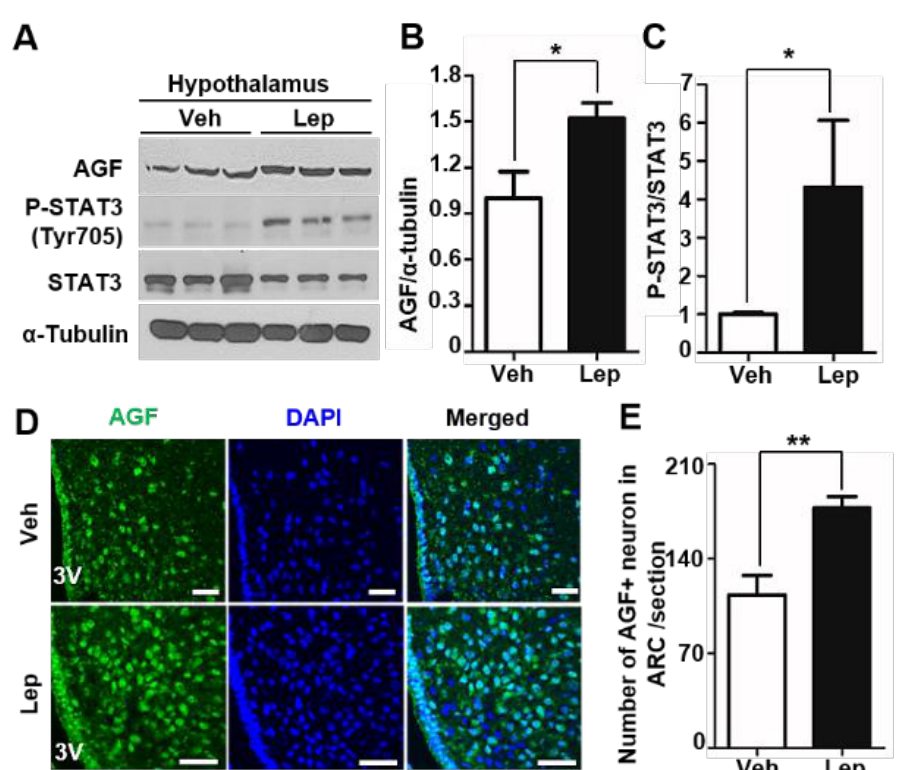
Figure 3. AGF expression is induced by leptin-stimulated signal transducer and activator of transcrip- tion 3 (STAT3) activation. ( A ) AGF level in the hypothalamus of C57BL/6 mice after intraperitoneal injection of recombinant mouse leptin (3 mg/kg) or vehicle, determined by Western blotting. AGF, pSTAT3 (Tyr705), STAT3 and α -tubulin were detected in tissue lysates containing equal amounts of protein from the hypothalamus of each group. ( B , C ) Band intensities of AGF and pSTAT3 measured by the ImageJ program; values are normalized to vehicle-injected samples. ( D ) AGF and DAPI (4 (cid:48) ,6-diamidino-2-phenylindole) co-staining in brain sections from leptin- or vehicle-injected mice. Immunoreactivity was detected by confocal microscopy. ( E ) Number of AGF-positive neurons in the ARC. Data represent means ± SEM (* p < 0.05, ** p <